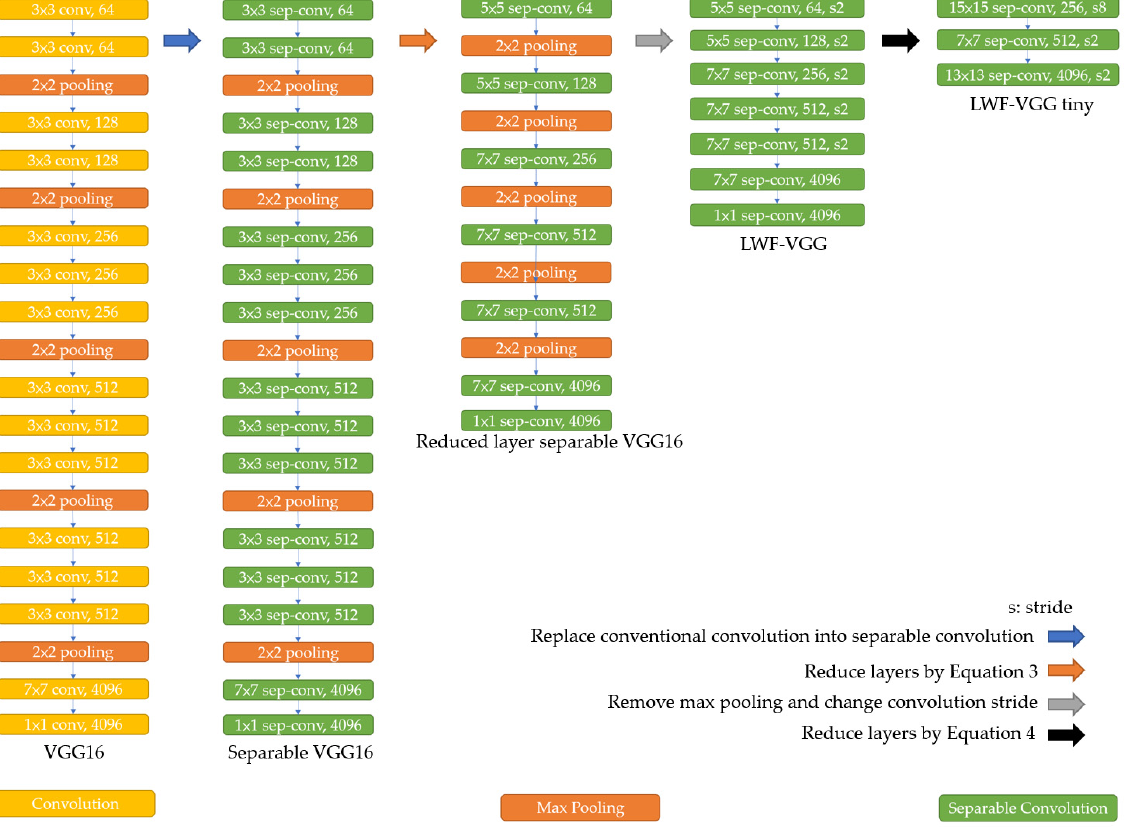
Figure 11. Light ‐ weight process of VGG16. Figure 11. Light-weight process of